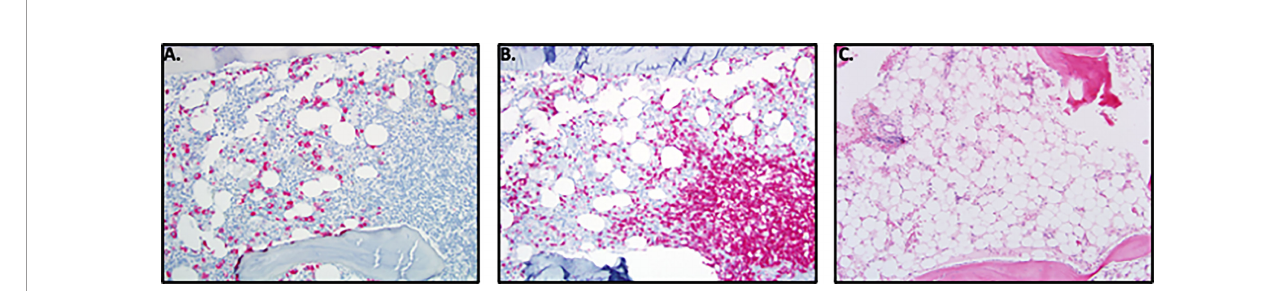
FIGURE 11 | Bone Marrow Findings in DADA2. (A) 16-year-old male with history of DADA2 with severe neutropenia (ANC=0.02 K/uL). The marrow, when stained for MPO shows myeloid hypoplasia with presence of decreased immature myeloid precursors and absence of maturing forms consistent with maturation block or loss of myelocytes, metamyelocytes and neutrophils by immune mechanism. (B) Prominent T-cell aggregates and T-cell in fi ltrate in marrow when stained for CD3 in the marrow of the 16 y/o male with neutropenia. (C) 11-year-old male with progressive pancytopenia while on TNF inhibition. Bone marrow biopsy revealed marked hypocellularity for age morphologically overlapping with aplastic anemia. There was severe myeloid and erythroid hypoplasia with rare